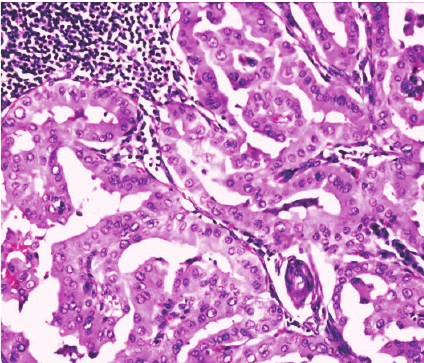
Figure 4: Hematoxylin and Eosin staining showing tall papillary cells (height at least twice or thrice their width), papillary thyroid carcinoma (the second case).